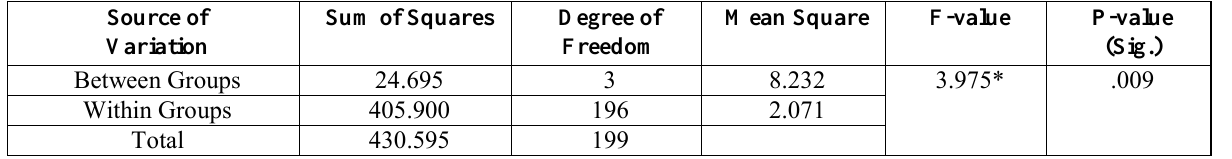
Analysis of Variance (ANOVA) results among North, East, West and South regions female baseball players with regard